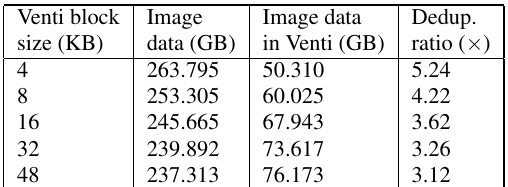
Table 1: Average throughput rate and execution time of each stage in the baseline Frisbee pipeline. Throughput values are measured relative to the uncompressed data, except for network transfer, which reflects compressed data (with uncompressed rate in parentheses). For all end-to-end image deployments, both the baseline Frisbee server and VF are configured to distribute data at a bandwidth of 500Mbps. Factoring out network and Frisbee protocol overheads, this translates to a maximum image data rate of 57.5MB/s.